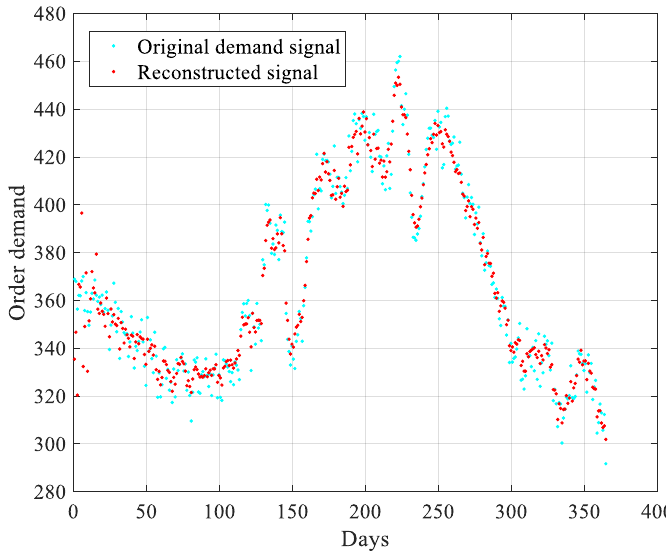
Figure 7. Reconstructed signal diagram.